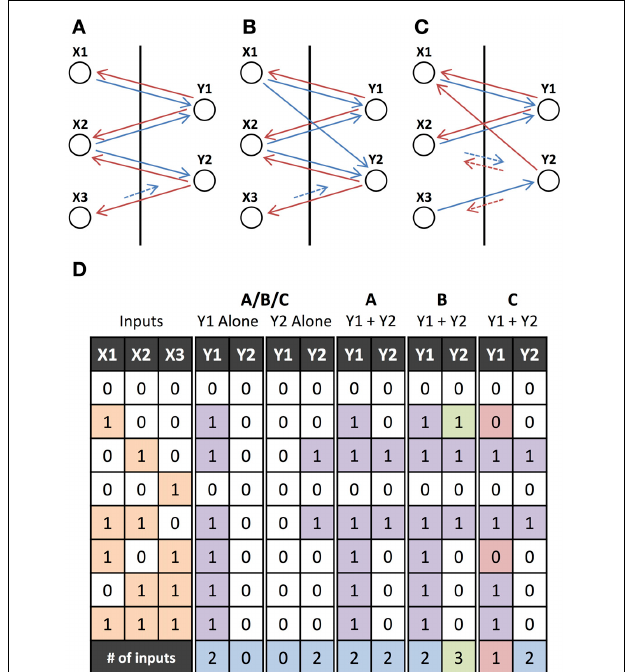
FIGURE 4 | Non-interacting and Interacting Operations. (A) Two output units, Y1 and Y2, which individually perform operations “X1 or X2” and “X2 and not X3,” respectively. Feedforward connections to input units from lower-level units and feedforward connections from output units to higher-level units (as shown in Figure 3 ) have been omitted. (B) Same as (A) but with an additional feedforward connection which does not change the individual operations but introduces interactions when they are initiated together. (C) Same as (A) but Y2 instead needs to be initiated in phase with the input units for it to perform the same operation. There is also an additional feedback connection that, similar to the additional connection in (B) , does not change the individual operations but introduces interactions. (D) Input-output table for the networks in (A–C) . The input units (or cues), X1, X2, and X3, either receive feedforward input (1) or not (0), and the output units, Y1 and Y2, are either activated (1) or not (0) for each of the networks initiated with external feedback to only Y1, only Y2, or to both Y1 and Y2. Green (red) outputs are ones that are activated (not activated) when the units are initiated together but were not activated (activated) when the units were initiated separately. The final row indicates the number of inputs that the output unit’s operation depends upon (relevant inputs), where green (red) indicates that the number has increased (decreased) from being initiated separately to being initiated